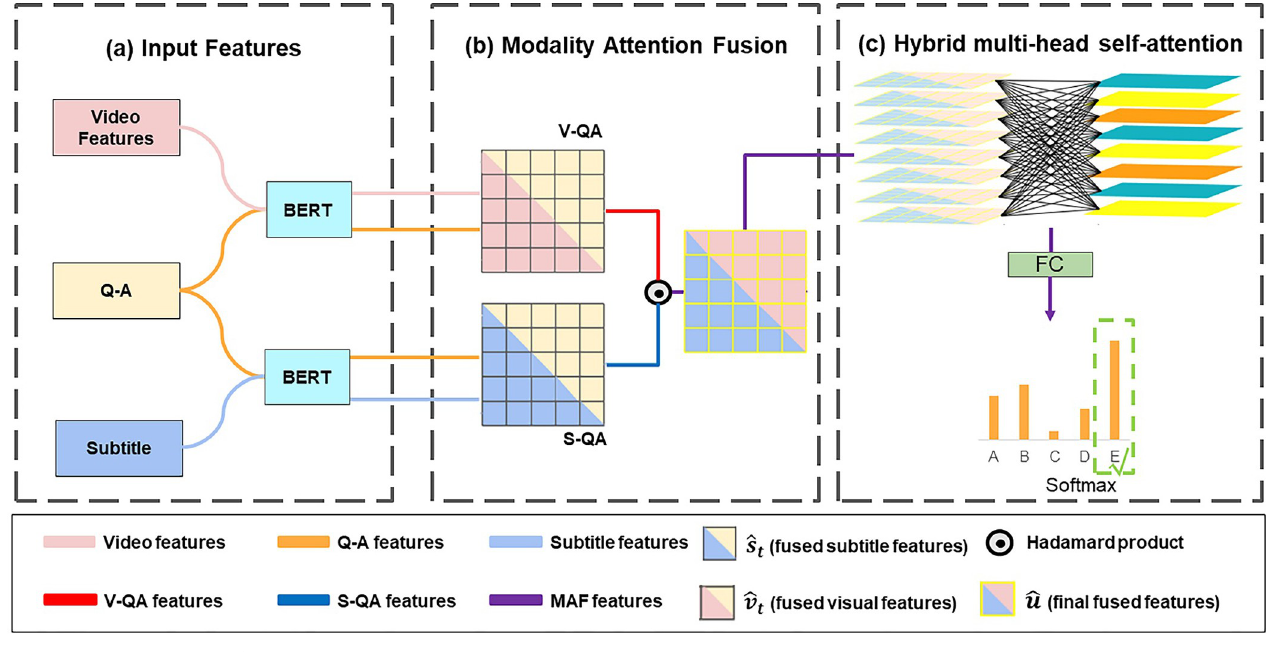
Fig 1. Faster R-CNN network. https://doi.org/10.1371/journal.pone.0275156.g001 layers, and use BERT to combine visual conceptual features and subtitles and questions with each candidate answer for embedding. These input features use modal attention fusion (MAF) and a hybrid multi-head self-attention (HMS) mechanism to obtain the final answer prediction.